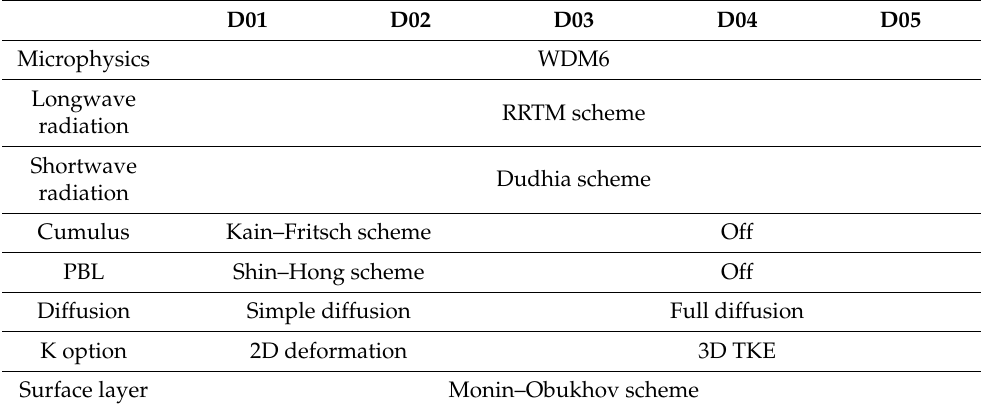
Table 2. Model physical parameterization settings for nested